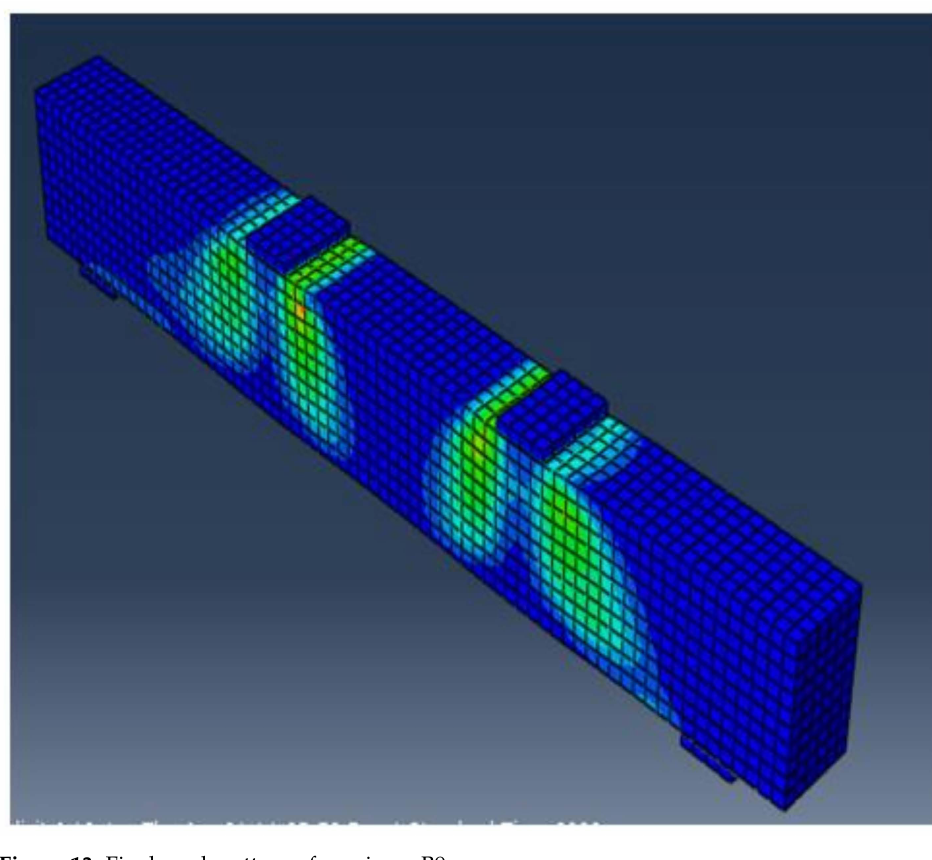
Figure 13. Final crack pattern of specimen B9.